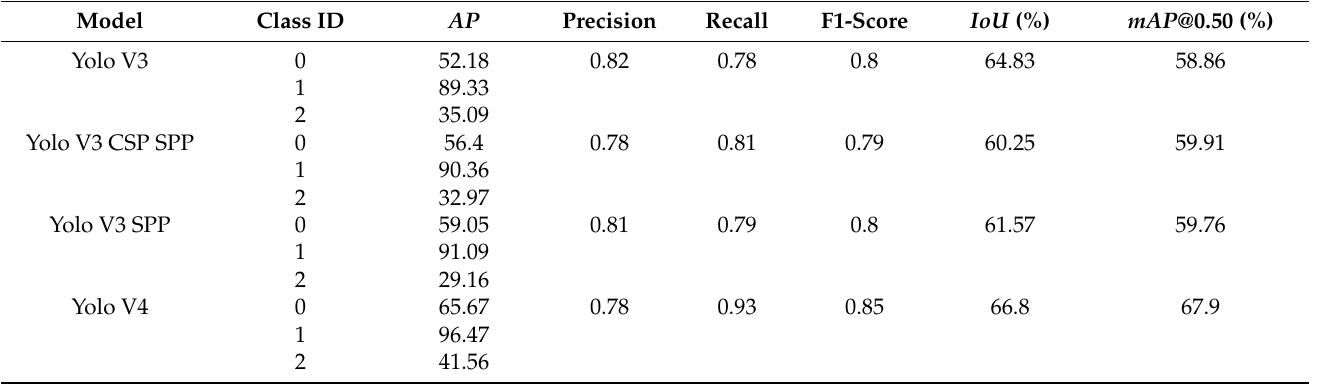
Table 1. Training performance for all models with FMD and MMD